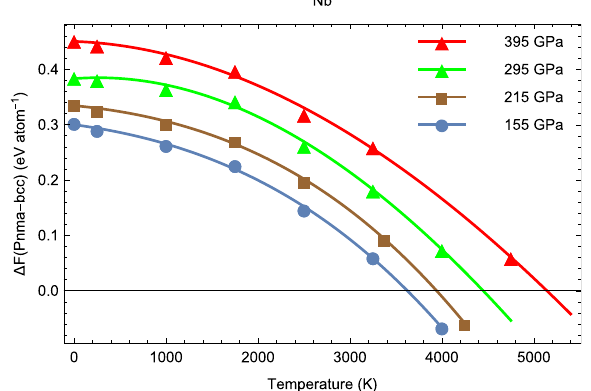
Fig. 8 The difference between the total free energies of orthorhombic Pnma -Nb and body-centered cubic bcc-Nb as a function of temperature at four different pressures. Error bars are smaller than the size of the corresponding